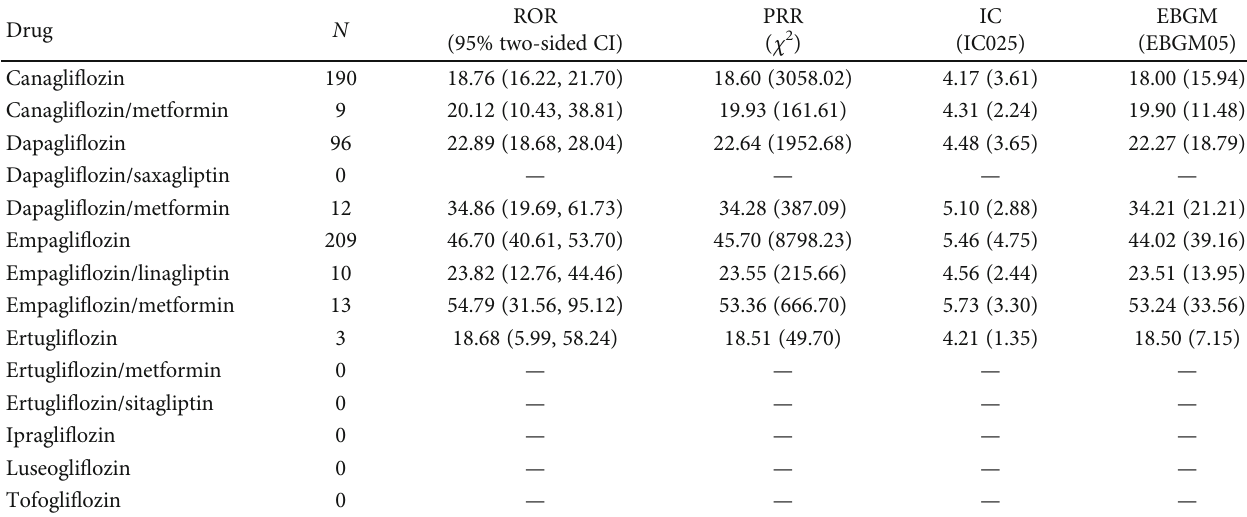
Table 4: The association between di ff erent SGLT2 inhibitors and FG